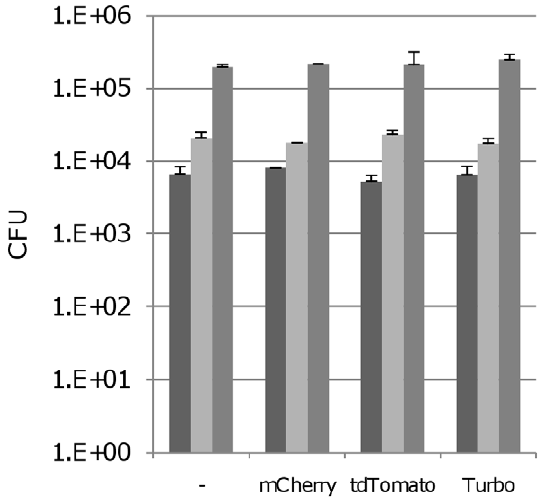
Figure 10. Virulence of M. tuberculosis fluorescent strains in murine macrophages. Murine macrophages were infected at an MOI of 1:1 with recombinant strains expressing the indicated reporter from P smyc . Bacterial counts were measured over a period of 7 days. Data are the mean and standard deviation from three independent infections. Time points for each reporter strain, from left to right are day 1, day 3 and day 7.